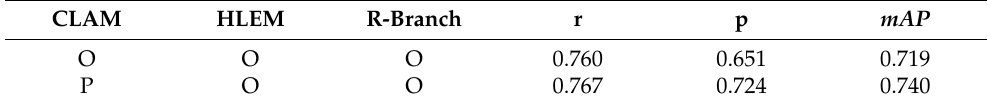
Table 10. Effectiveness of CLAM when the other two modules are not added. CLAM